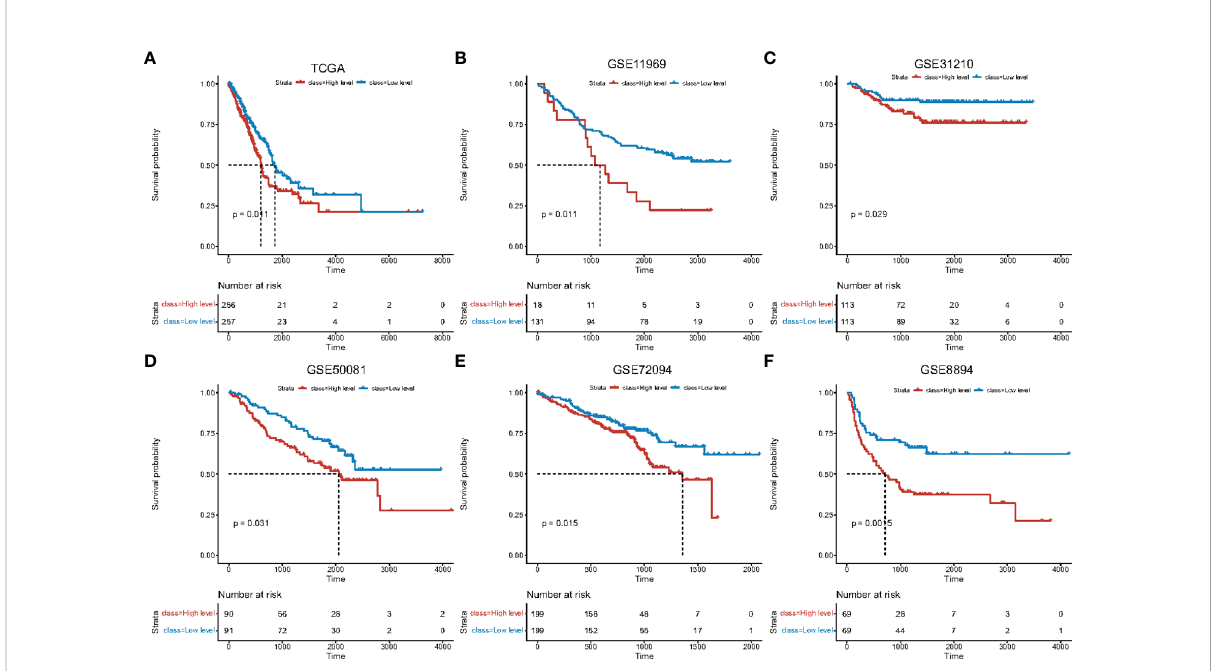
FIGURE 1 Survival curves of high and low macrophage in fi ltration in lung adenocarcinoma datasets. Horizontal axis: survival time. Vertical axis: survival probability. Color: level of macrophage in fi ltration. Survival analysis using (A) TCGA data, (B) GSE11969, (C) GSE31210, (D) GSE50081, (E) GSE72094, (F)